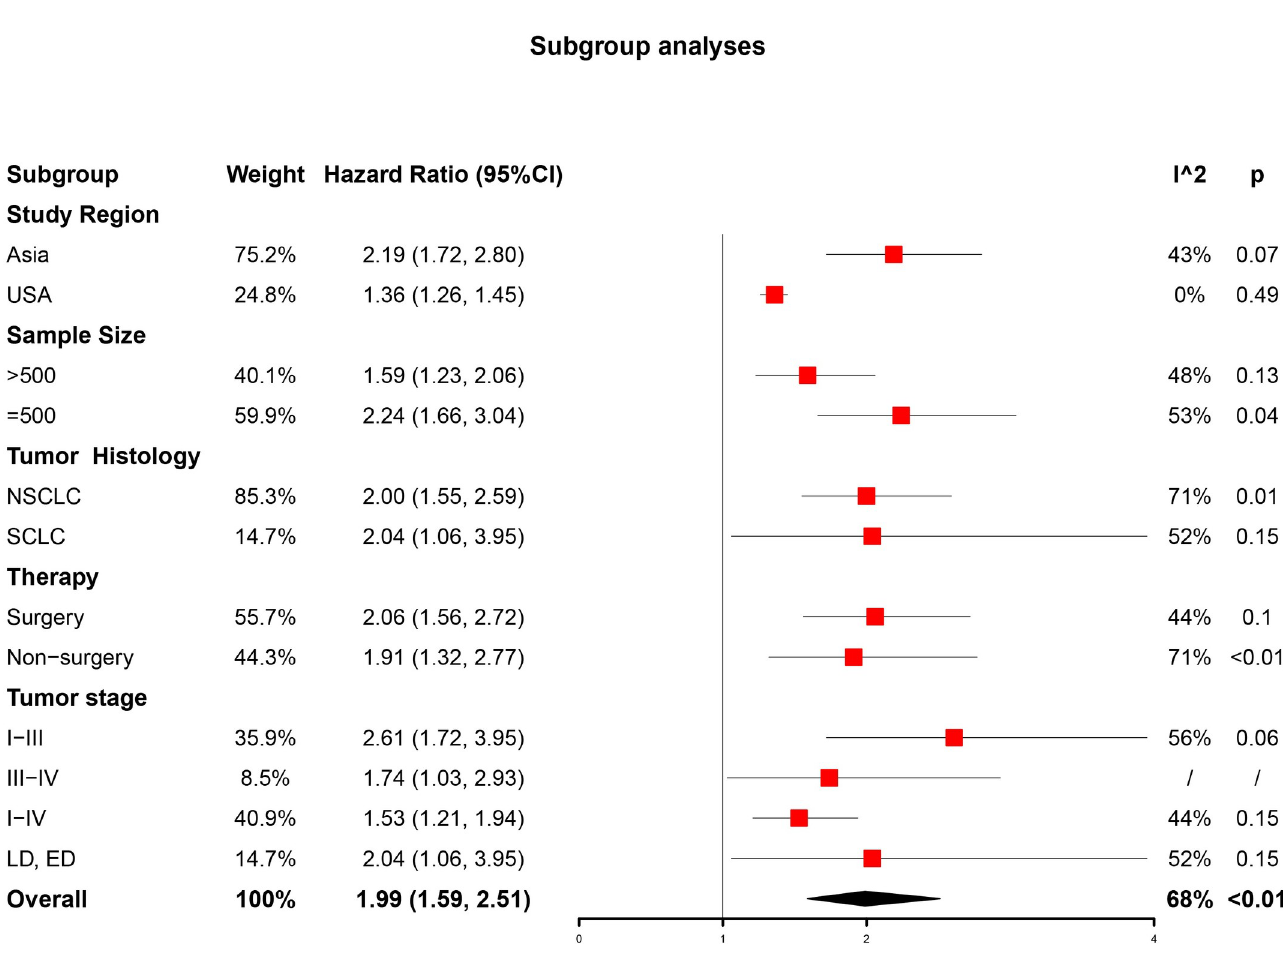
Fig 3. Subgroup analyses of association between concomitant IPF and OS in different population.